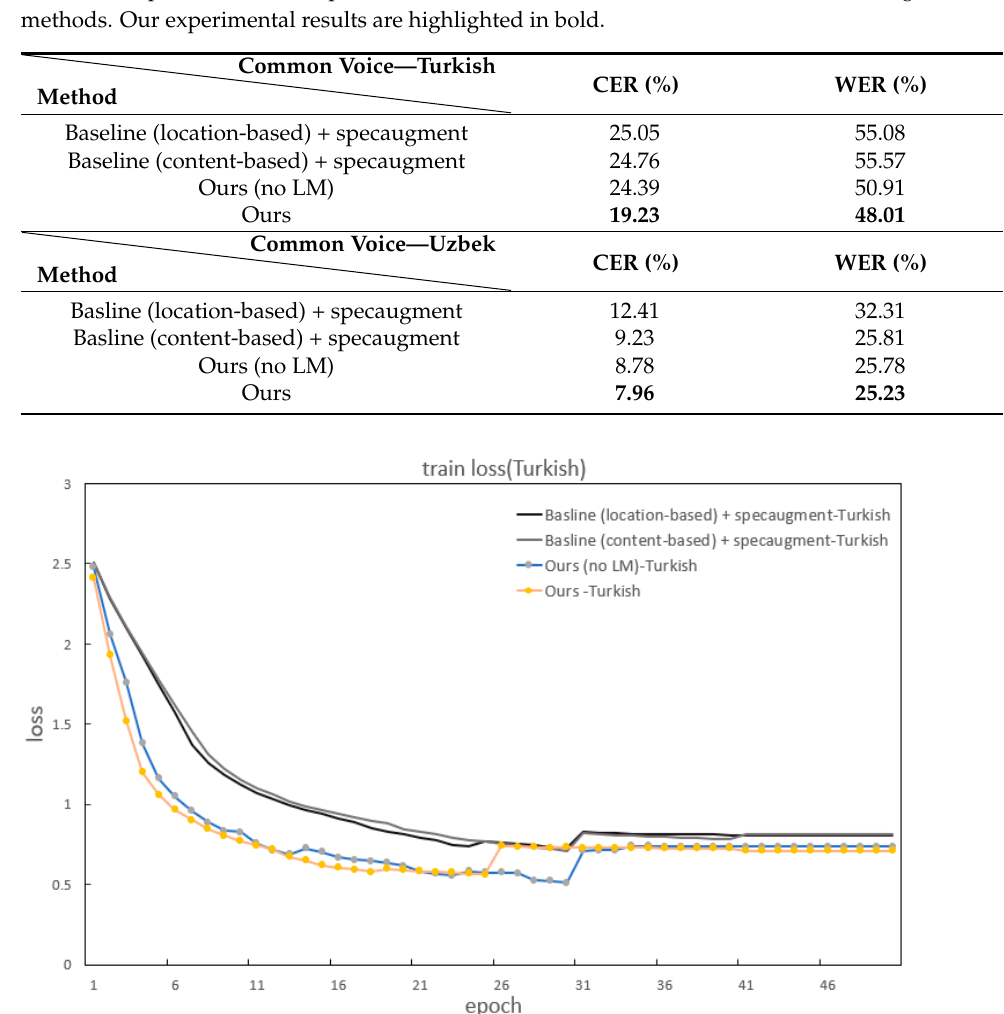
Figure 7. The train loss of the baseline and our methods for Turkish.